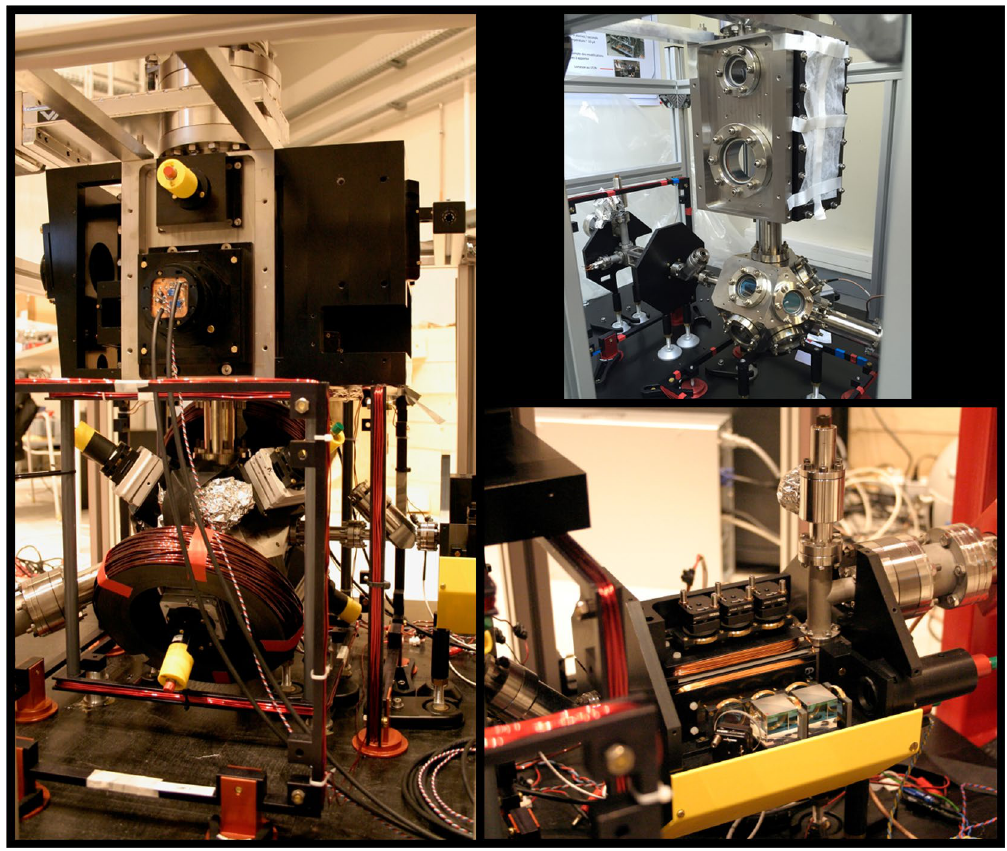
Figure 2. Photos of the cold atoms unit. Left: MOT and preparation/detection chamber with optics and magnetic coils. Top right: the complete vacuum system of the atom head without optics. Bottom right: The 2D MOT chamber with optics and magnetic